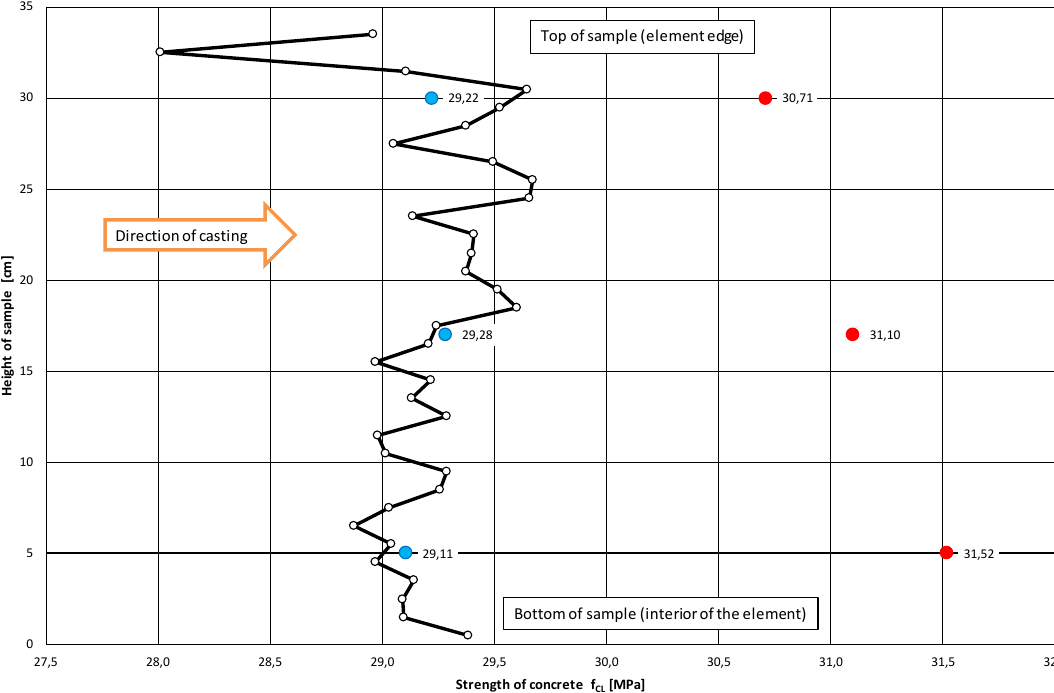
destructive tests (marked red).